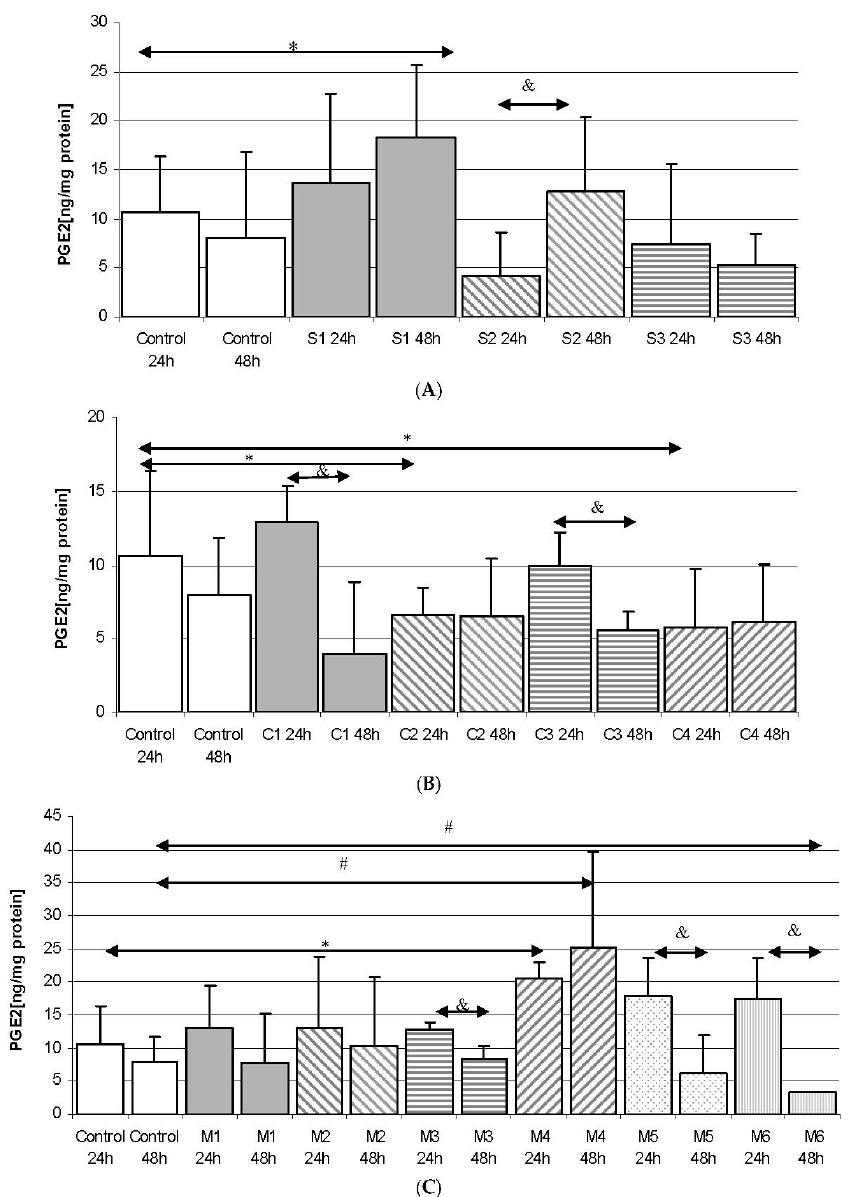
Figure 2. The concentration of prostaglandin E 2 (PGE 2 ) in THP-1 monocytes cultured with various plates and dedicated screws used for surgical treatment of patients with condylar fractures. THP-1 cells were cultured for 24 h and 48 h in RPMI medium with 10% FBS with various plates and dedicated screws: ( A ) SYNTES (S1, S2, S3); ( B ) MARTIN (C1, C2, C3, C4); ( C ) MEDARTIS (M1, M2, M3, M4, M5, M6), for details see Table 1. After incubation the cells were harvested by scraping and PGE 2 concentration was measured by ELISA. Experiments were conducted as six separate assays, each assay in three replicates, ( n = 18). * Statistically significant differences in comparison to control 24 h ( p ≤ 0.05), # Statistically significant differences in comparison to control 48 h ( p ≤ 0.05), & Statistically significant differences in comparison to appropriate plate 24 h ( p ≤ 0.05). Control cells were incubated in RPMI medium with 10%